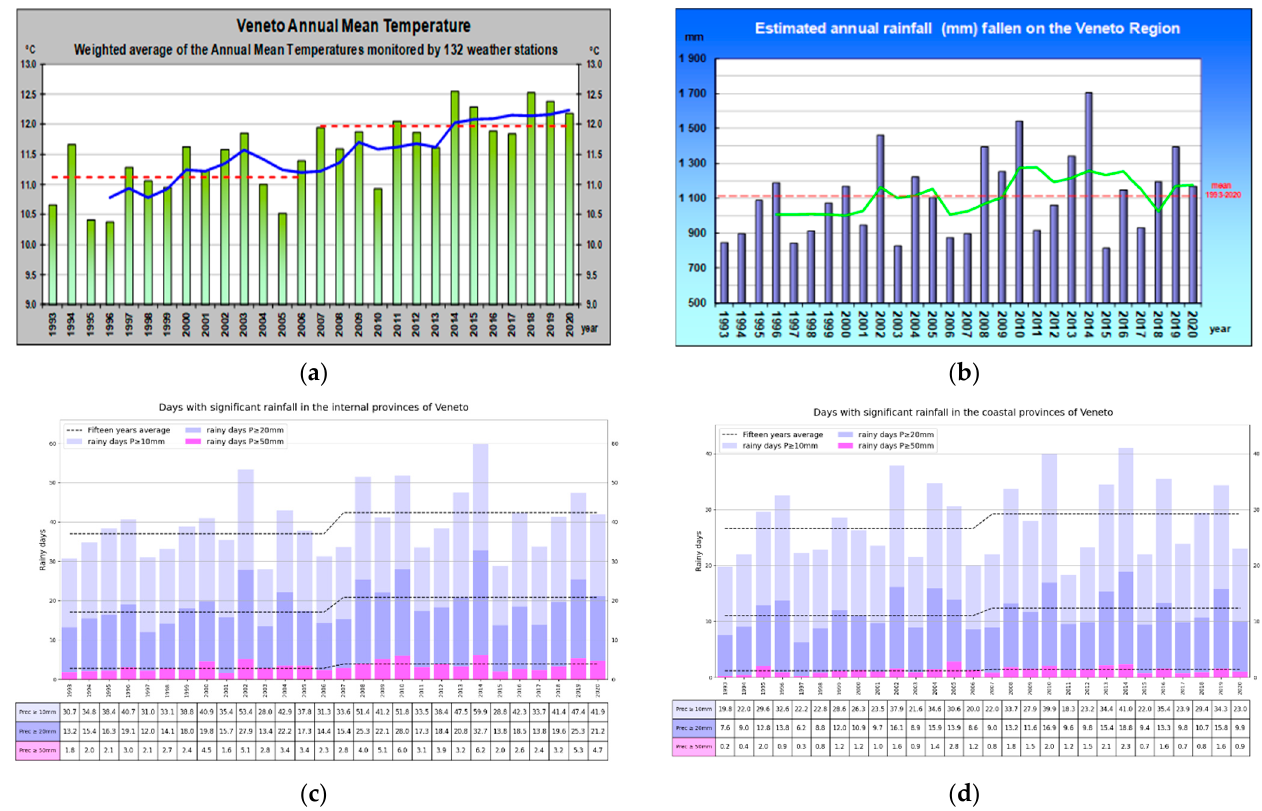
Figure 2. Trend in the last 28 years of average annual temperatures in Veneto (considering 132 meteorological stations). The red dotted lines represent the average in the first and subsequent 14 years (increase of about 0.8 °C). The blue line represents the 4-year moving average and also, in this case, the increase over time is well highlighted ( a ). Estimation of the annual rainfall of the period 1993–2020 that fell on the Veneto region, elaborated by spatializing the measurements carried out by 160 rain gauge stations. The red dotted line represents the 1993–2020 average. The green line represents the 4-year moving average. A tendential increase in rainfall is observed in the period 2008–2014 ( b ). Days with significant precipitation for the period 1993–2020 in the hilly and mountainous provinces of Veneto ( c ). Days with significant precipitations for the period 1993–2020 in the coastal provinces of Veneto ( d ).